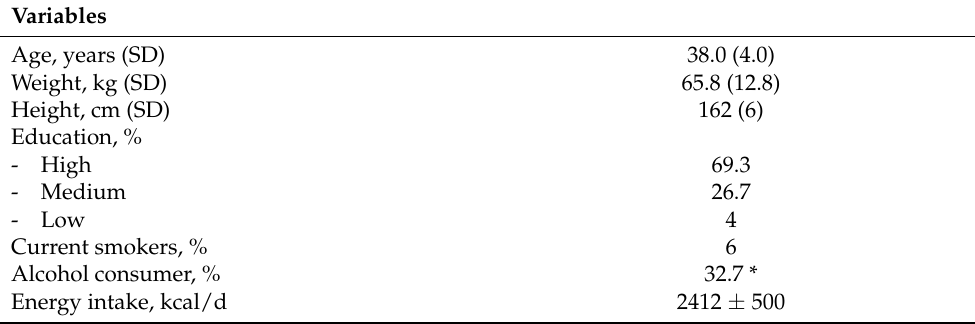
Table 1. General characteristics of the participants ( n =